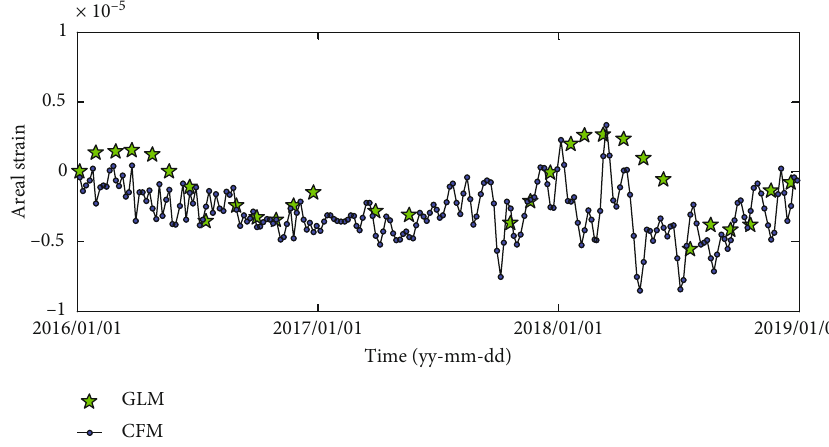
Figure 8: Comparison of the estimated areal strains from the GLM and CFM